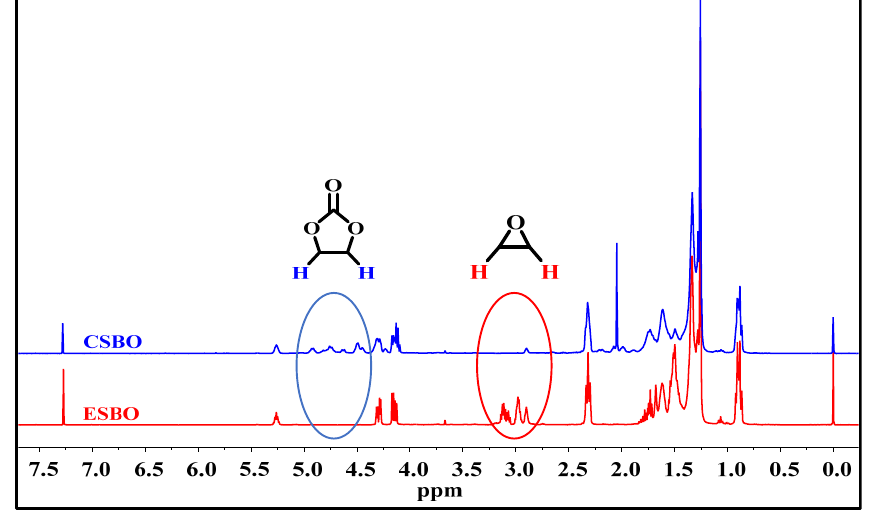
Figure 4. 1 H NMR of ESBO and CSBO.